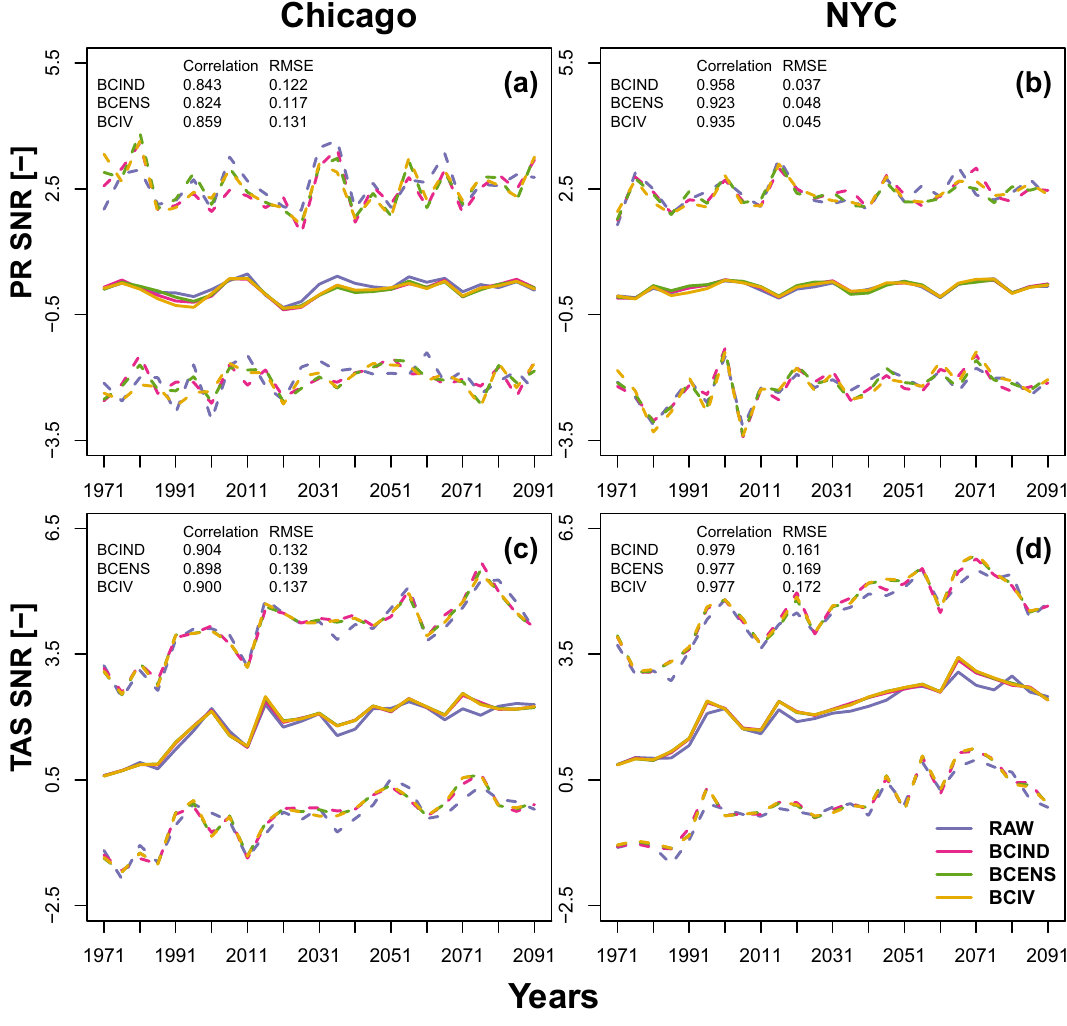
Figure 5. SNR for annual total precipitation ( a , b ) and mean temperature ( c , d ) over the 1961–2099 period for Chicago ( a , c ) and New York ( b , d ). The blue, purple, green and yellow solid lines represent respectively the raw and the BCIND, BCENS and BCIV corrected ensembles SNR for each 20-year periods. The dashed lines represent the maximum and minimum SNR boundaries defined respectively as max(trends) sd(trends) and min(trends) sd(trends)